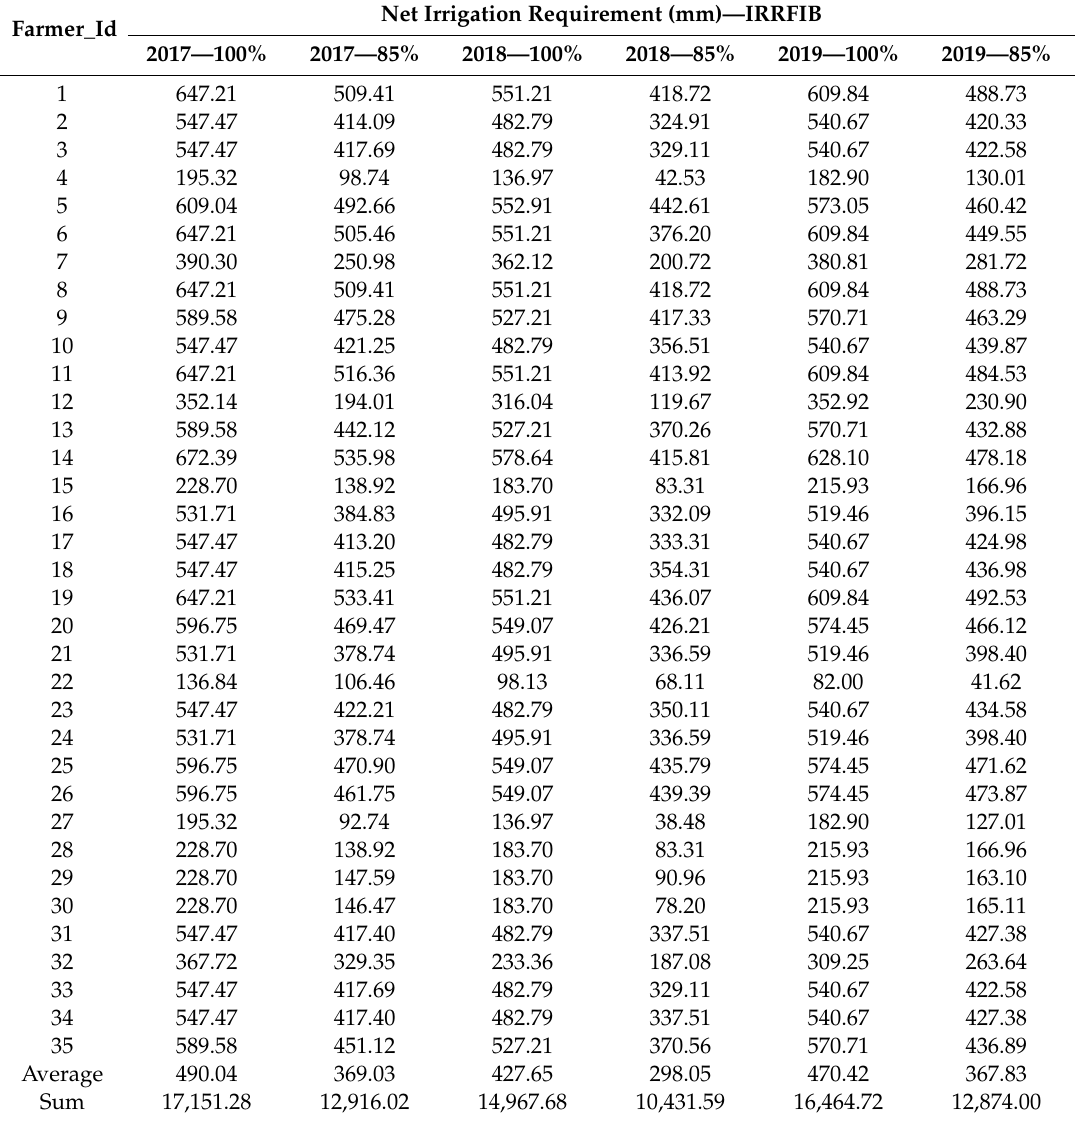
Table A4. Yearly net irrigation requirement (mm) at farm